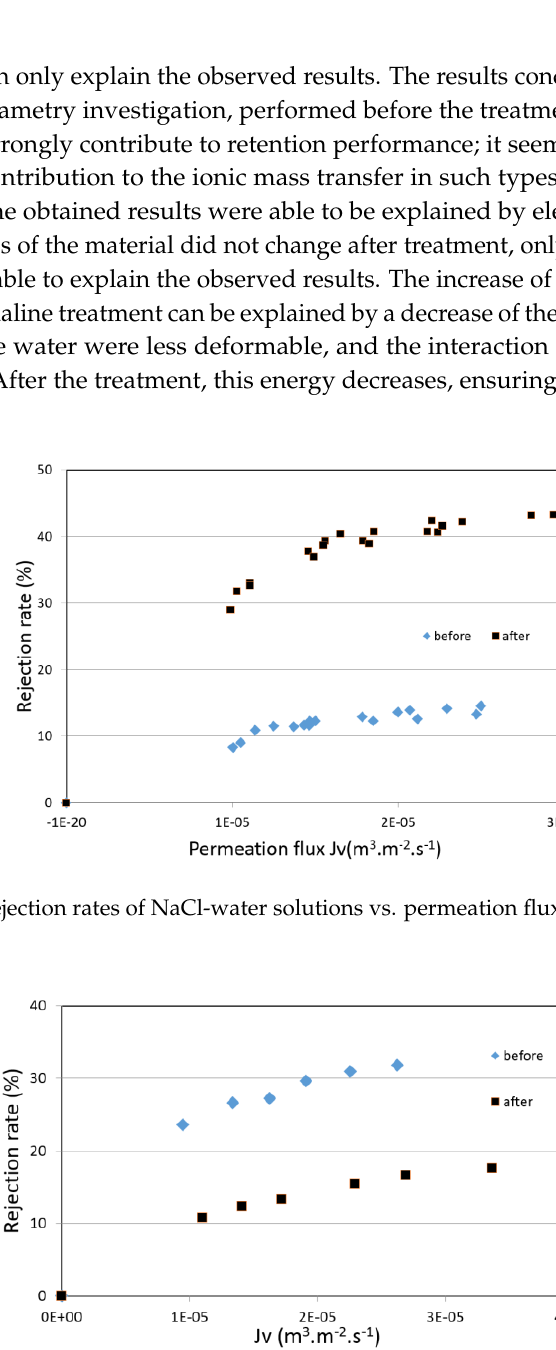
Figure 9. Best-fitted values ( X d , ε p ) for the numerical approximation of rejection curves. Although the right couple cannot be determined from pure salt solutions, Figure 9 enables a relevant quantitative discussion. Indeed, if the charge density inside the pores is assumed to be very weakly impacted by the alkaline treatment, the simulations show that the dielectric constant is necessarily modified by the treatment. In the case of NaCl, the identified dielectric constant tends to be decreased by the treatment (higher dielectric exclusion), while the value increases for NaF, leading to lower dielectric exclusion. It is obvious that the selectivity order inversion between these two salts is probably due to both phenomena, but dielectric contribution is probably the predominant mechanism. 5. Conclusions The filtration properties and the performances of three commercial membranes were studied. Filtration tests of different pure salt-water solutions with a common ion were performed before and after an alkaline treatment. Before the treatment, the filtration tests of the ionic solutions show the following rejection order NaF > NaCl ≈ NaBr > Na 2 SO 4 > NaI. From these results, and taking into account the various characterizations performed, we can state that steric and electric effects alone cannot explain such an order of rejection. Only the dielectric effects are able to partially explain these results, especially according to the ion polarizabilities. After the alkaline treatment, the rejection